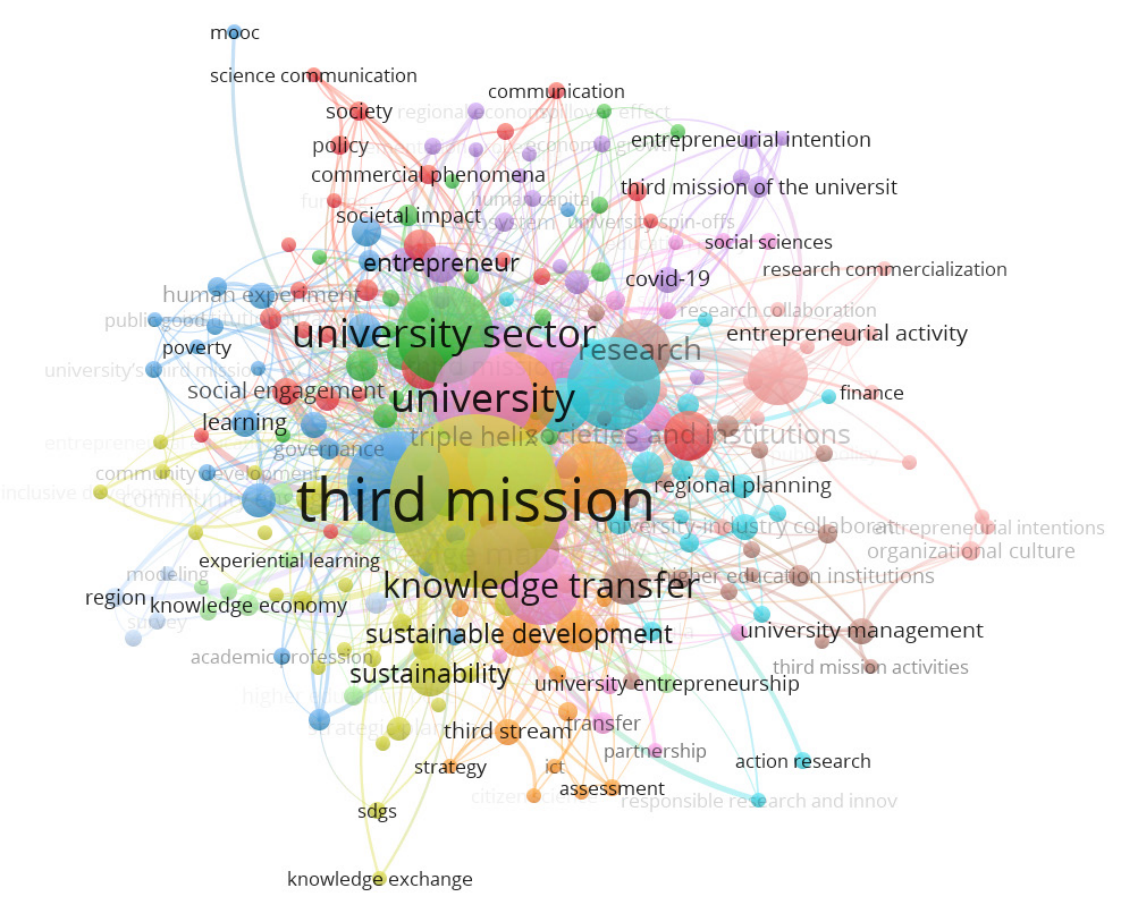
Figure 4. Map of clusters by co-occurrence of keywords on the third mission of the university